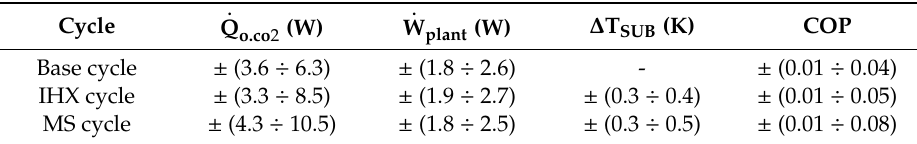
Table 2. Uncertainty range for the indirect measured